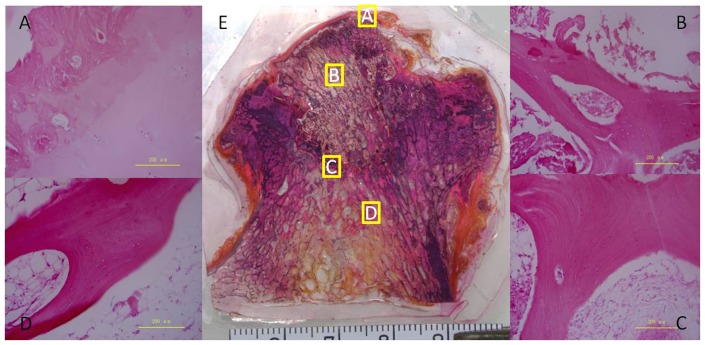
H&E staining of undecalcified and decalcified bone tissue.HE staining of a paraffin section of the subchondral bone (A), necrotic (B), sclerotic (C), and healthy(D) regions. HE staining of an undecalcified bone tissue slice of an entire section (E).